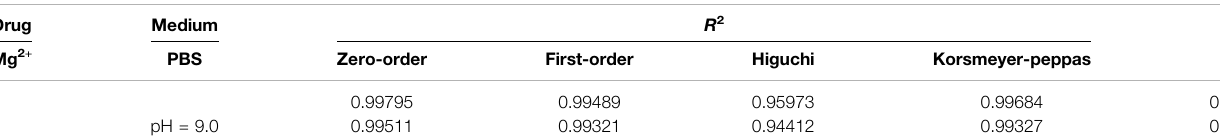
TABLE 1 | The release kinetic models of Mg 2+ @GG/PAM hydrogel.